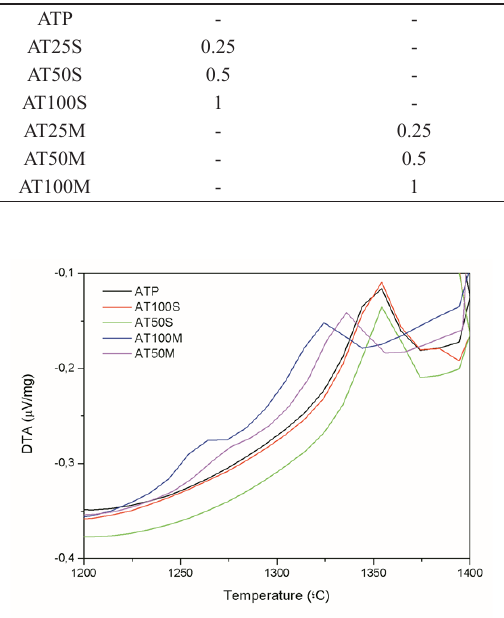
Figure 1. Differential thermal analysis (DTA) curves of samples from 1200 to 1400 °C.